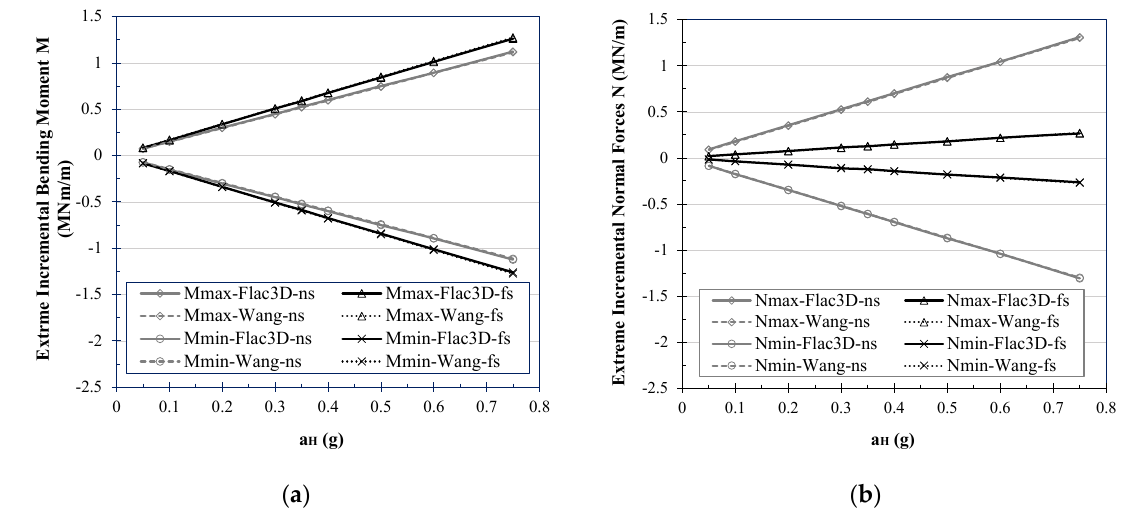
Figure 5. Effect of a H on the extreme incremental internal forces of the circular tunnel lining. ( a ) Extreme incremental bending moments; ( b ) Extreme incremental normal forces.